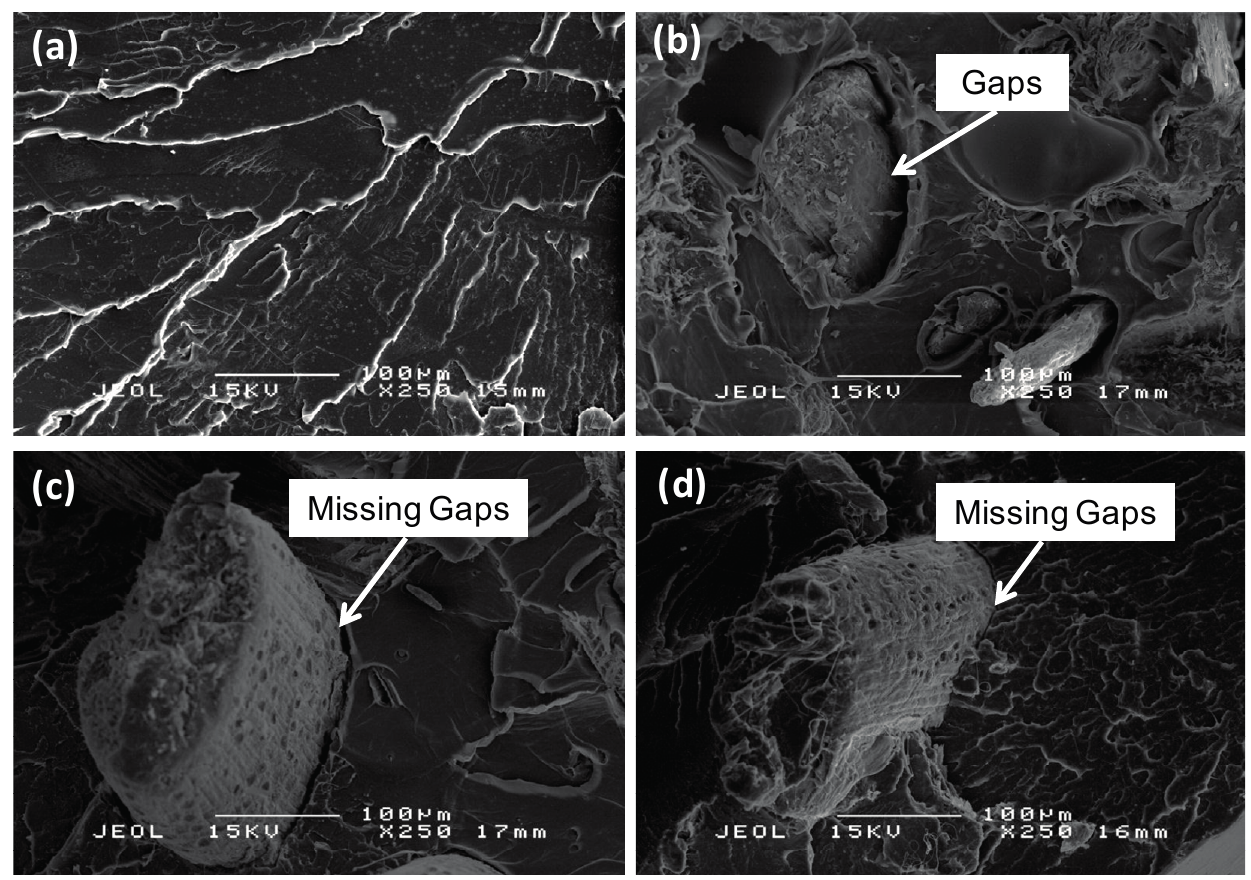
Figure 10. SEM micrographs of ( a ) PLA; ( b ) PLA/UTF; ( c ) PLA/BF; and ( d ) PLA/MB/BF.